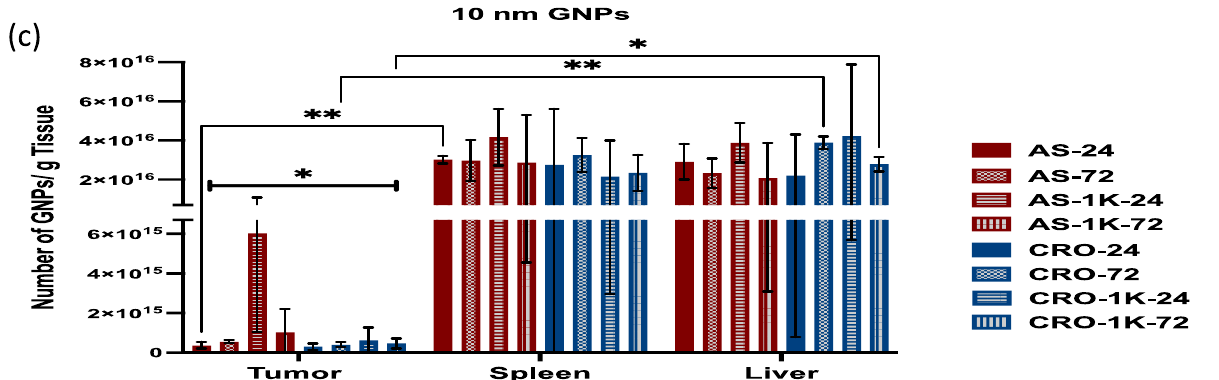
Figure 8. Quantification of 10 nm GNP accumulation in the tumor, liver, and spleen of mice that were injected with non-PEGylated and PEGylated (PEG Mw: 1 kDa) particles 24 and 72 h post-injection. ( a ) The percentage of the injected dose in tumor cells. ( b ) The percentage of the injected dose in the liver and spleen. ( c ) The number of GNPs/g tissue. Each data point represents the mean ± standard deviation (SD) of triplicate experiments. * denotes p < 0.05 and ** denotes p < 0.01.